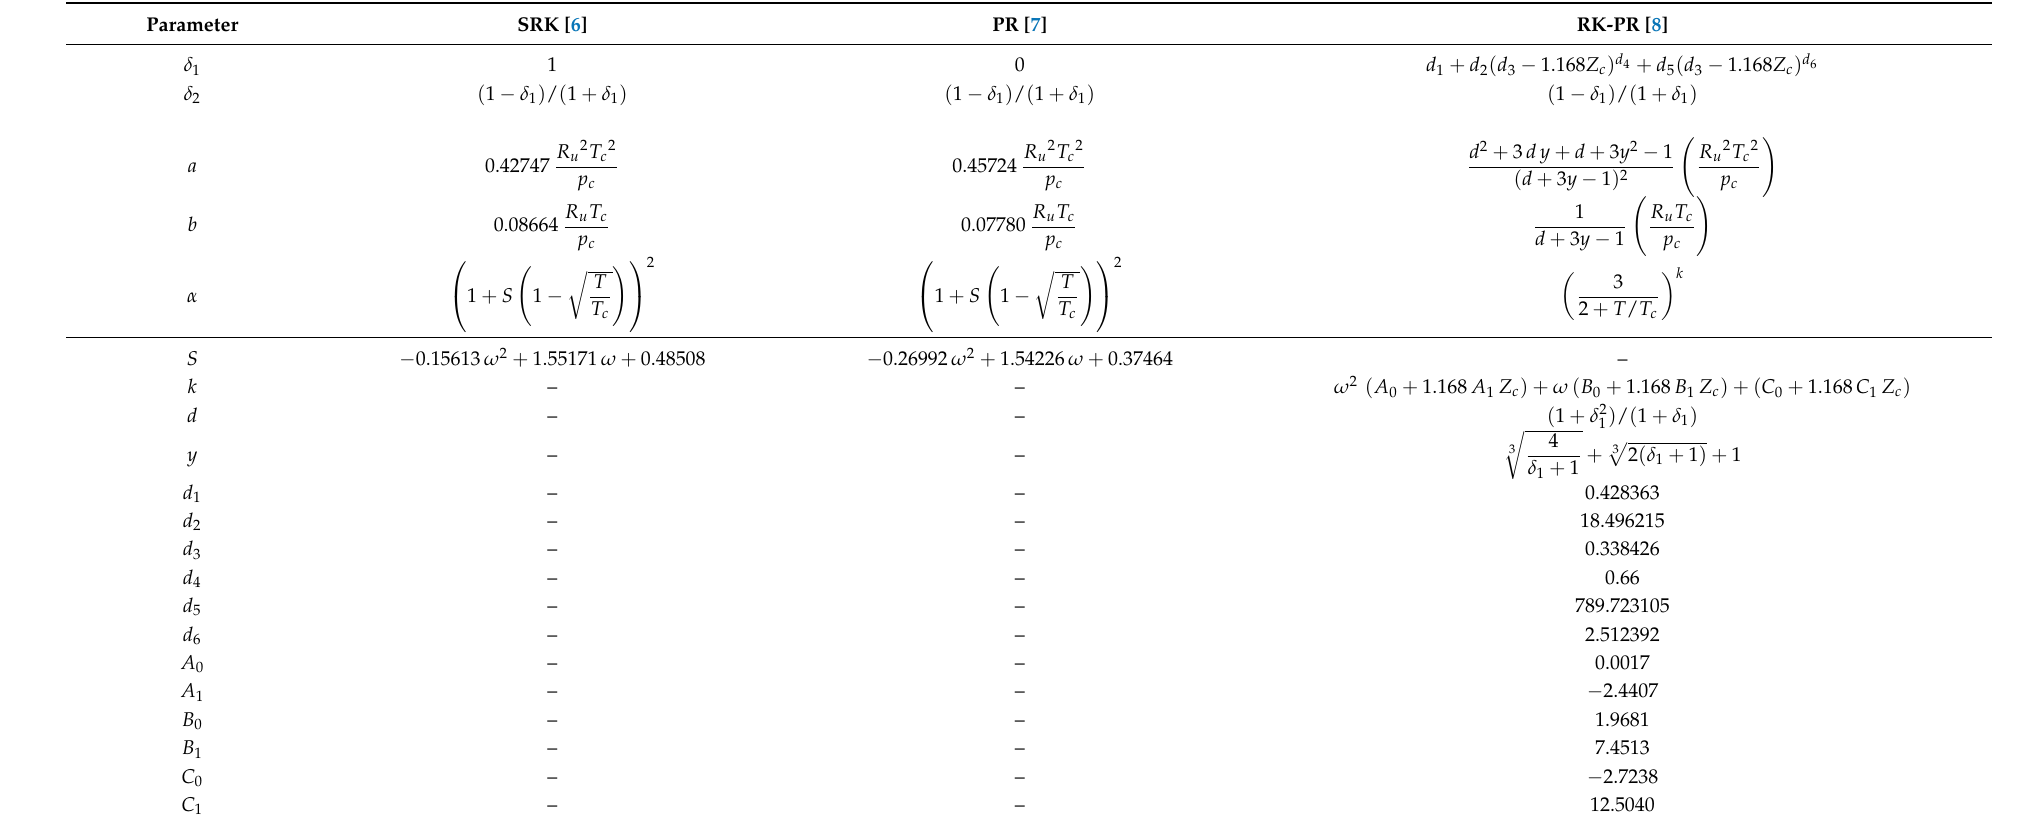
Table 1. Characteristic parameters of the three EoSs. Subscript “ c ” stands for critical and, thus, refers to quantities evaluated at the species critical